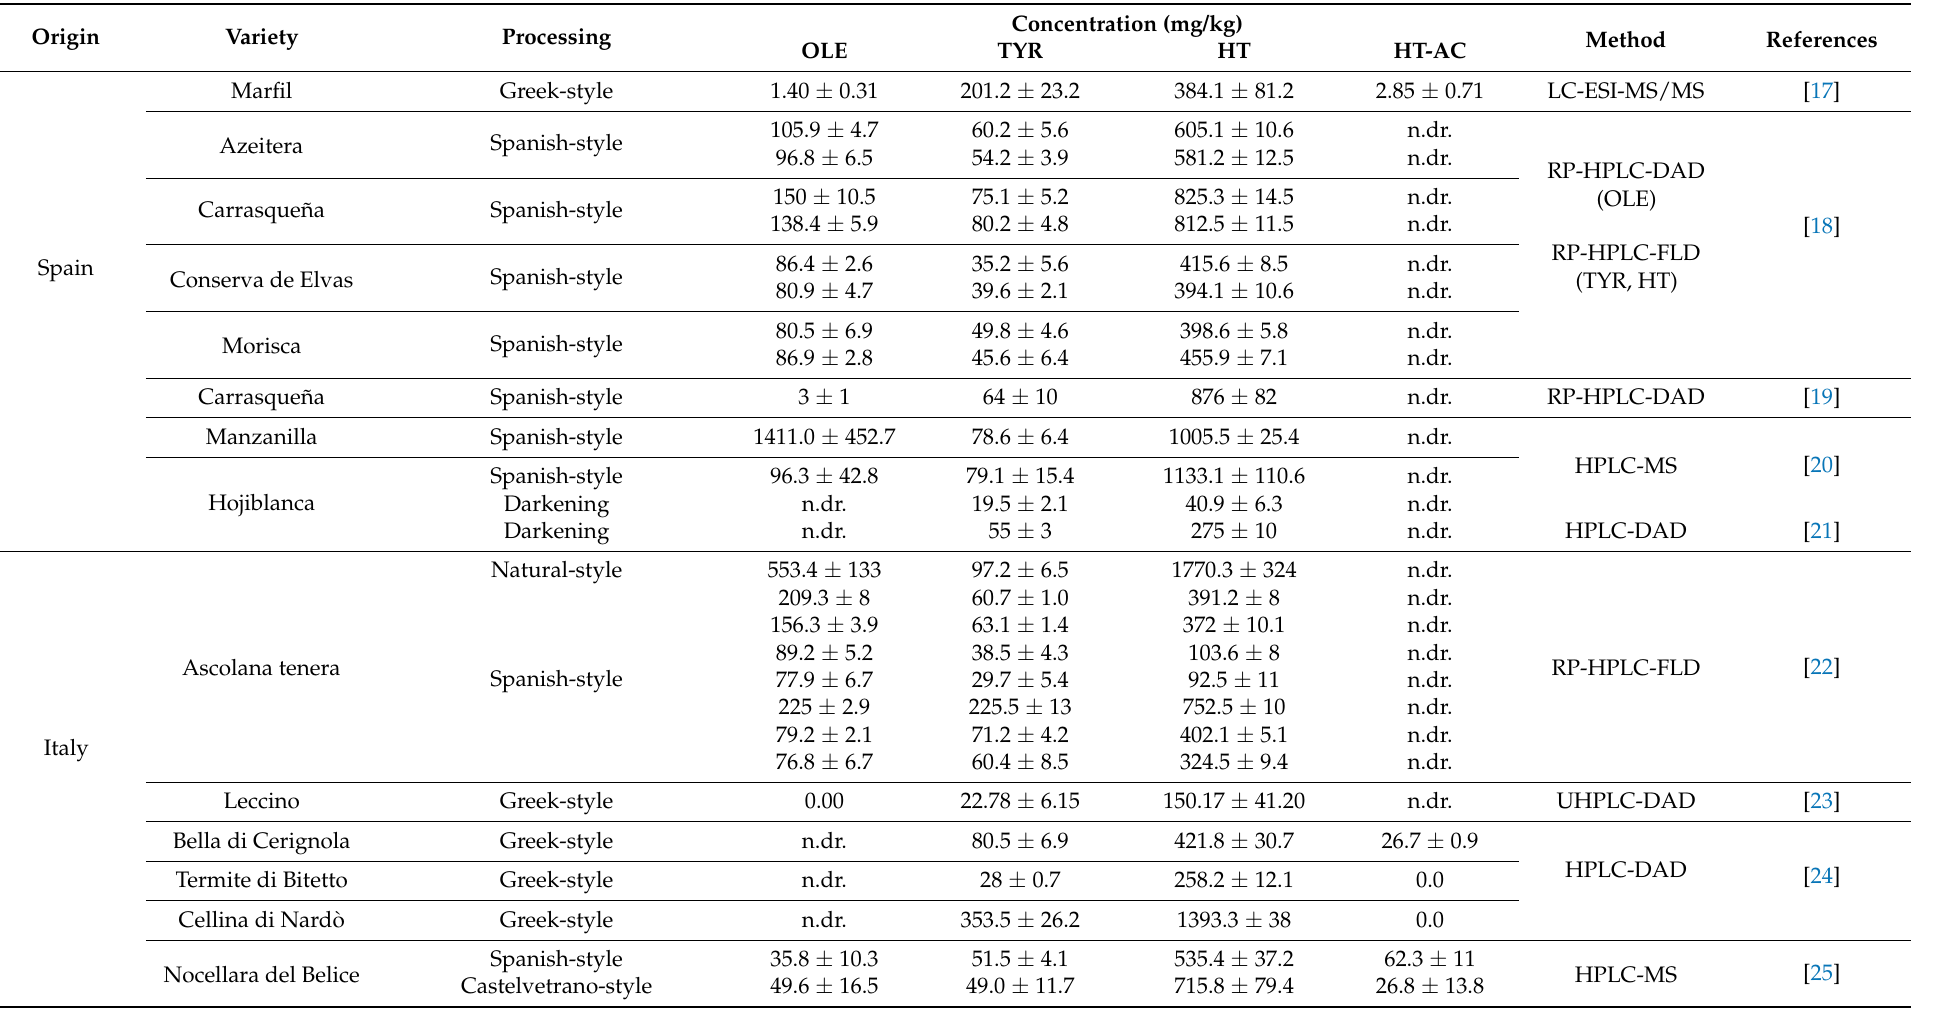
Table 1. Oleuropein (OLE), tyrosol (TYR), hydroxytyrosol (HT) and hydroxytyrosol acetate (HT-AC) concentration (mg/kg) in table olive samples according to origin, variety, processing and analytical